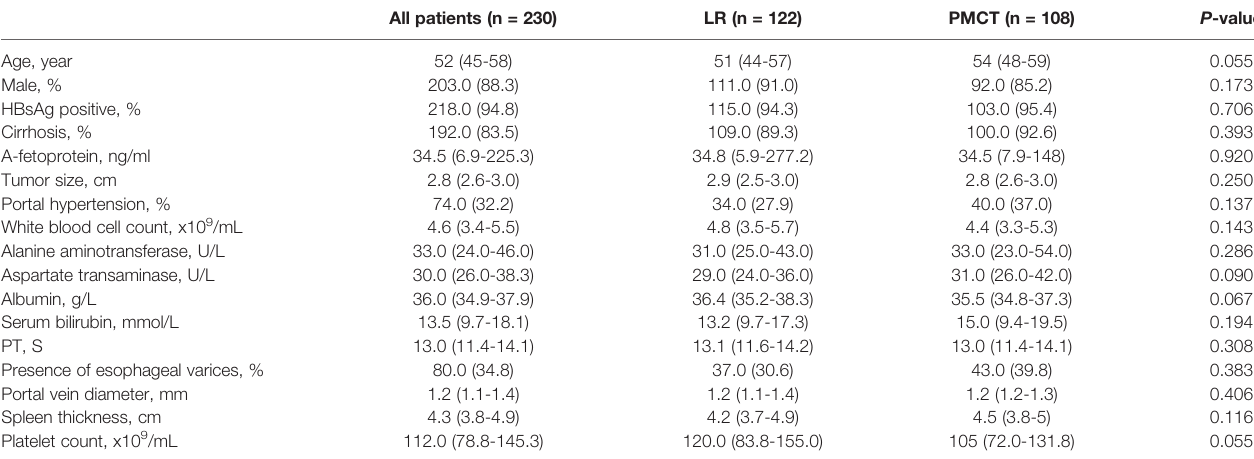
TABLE 2 | Patient demographic and clinical characteristics.